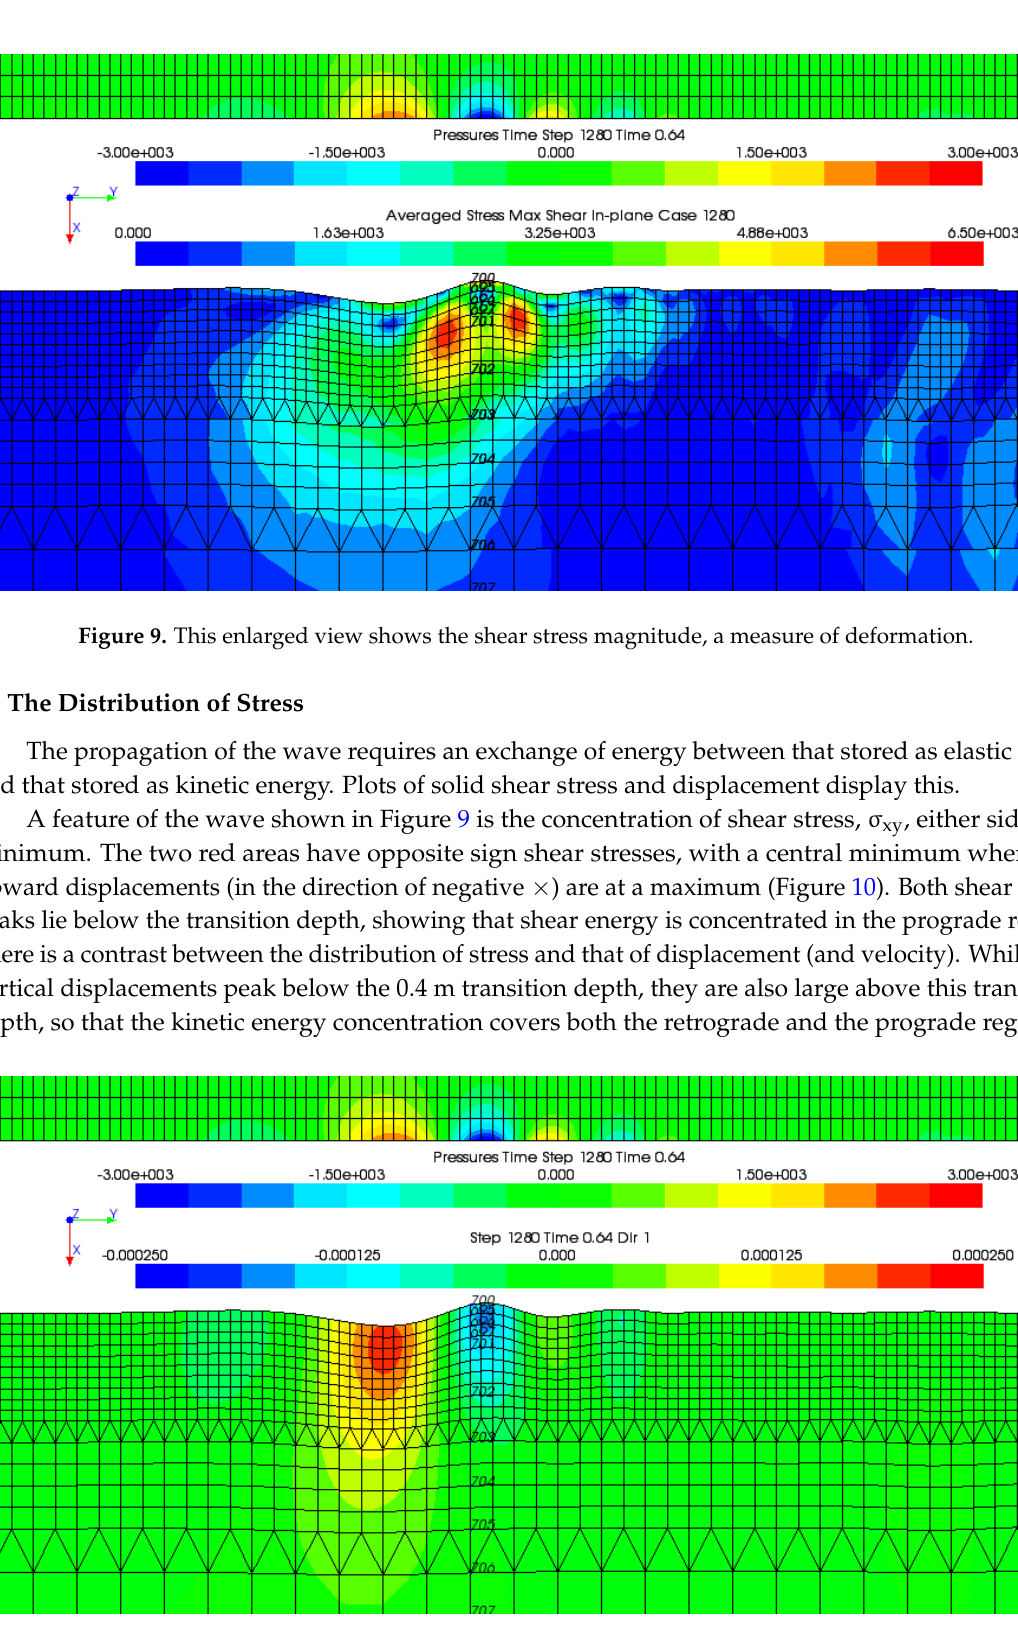
Figure 10. Vertical displacements deform the shape of the solid finite elements, storing energy.